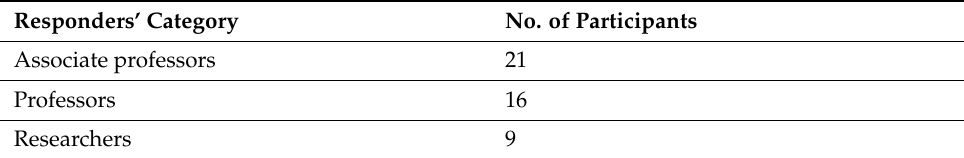
Table 1. Responders’